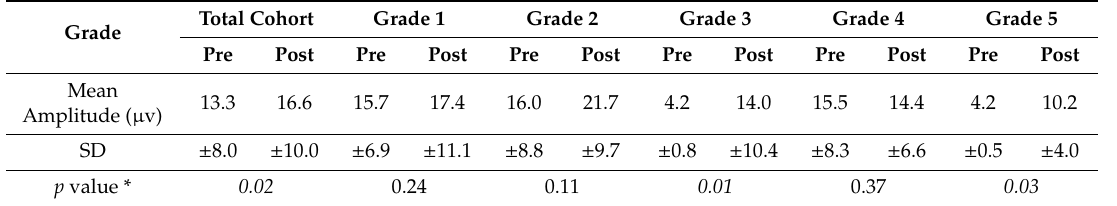
Figure 1. Postoperative changes in pVEP grades within 6 months for the whole cohort. Subsequent pVEP testing was performed within 1 year later for patients with grades 4 and 5 who had a persistent pVEP abnormality; pVEP, patterned, visually-evoked potentials. Table 2. Pre- to post-operative changes in pVEP amplitude for the total cohort and different grades, within 6 months after surgery. Increased amplitude indicates improvement.